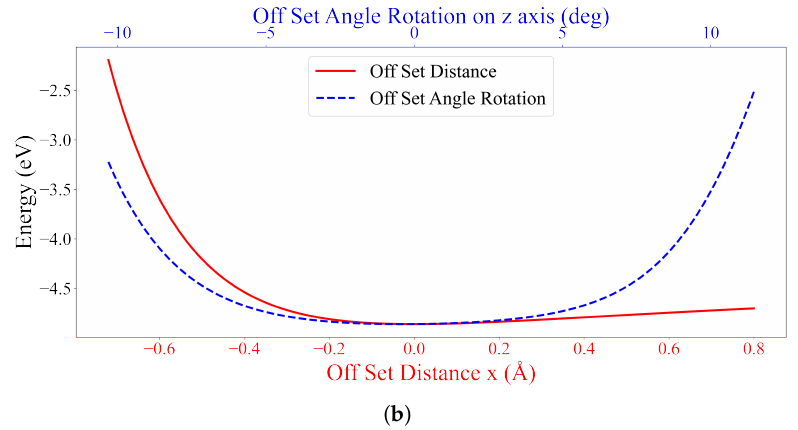
Figure 8. Energy values of ( a ) seed III-9 for Type B1 and ( b ) seed III-8 for Type B2 with offset positions in the x -direction (Å) and offset angles on the z -axis (degrees) between two DOXHs and